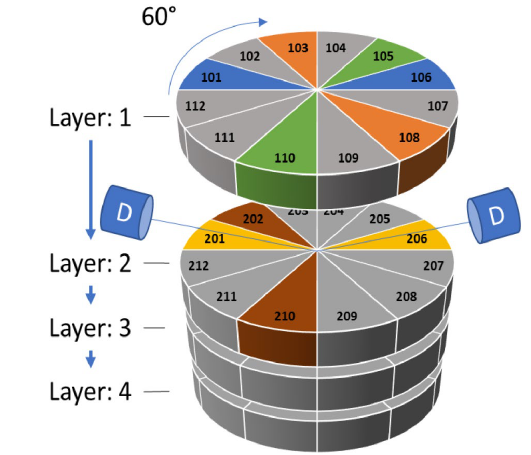
Fig. 1. Sketch of segmentation of the drum and the position of the HPGe- detectors. The drum is virtually divided in four horizontal layers of an approximate height of 20 cm. Each layer is subdivided into 12 segments. The two segments in front of the HPGe-detectors of each layer are measured simultaneously, as indicated by the color coding. The three digit segment code consists of the layer number and the serially numbered segment code. In this sketch, the neutron generator is located in the